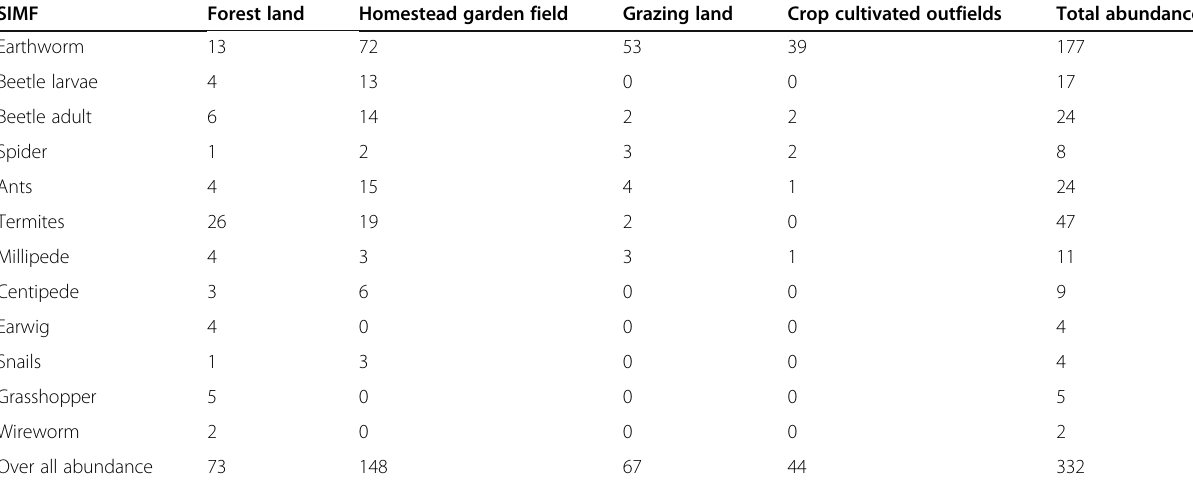
Table 5 Abundance of SIMF in four land use classes at Shenkolla watershed SIMF